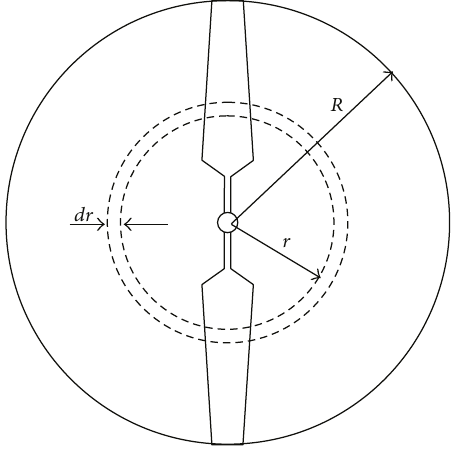
Figure 2: The propeller as a rotor